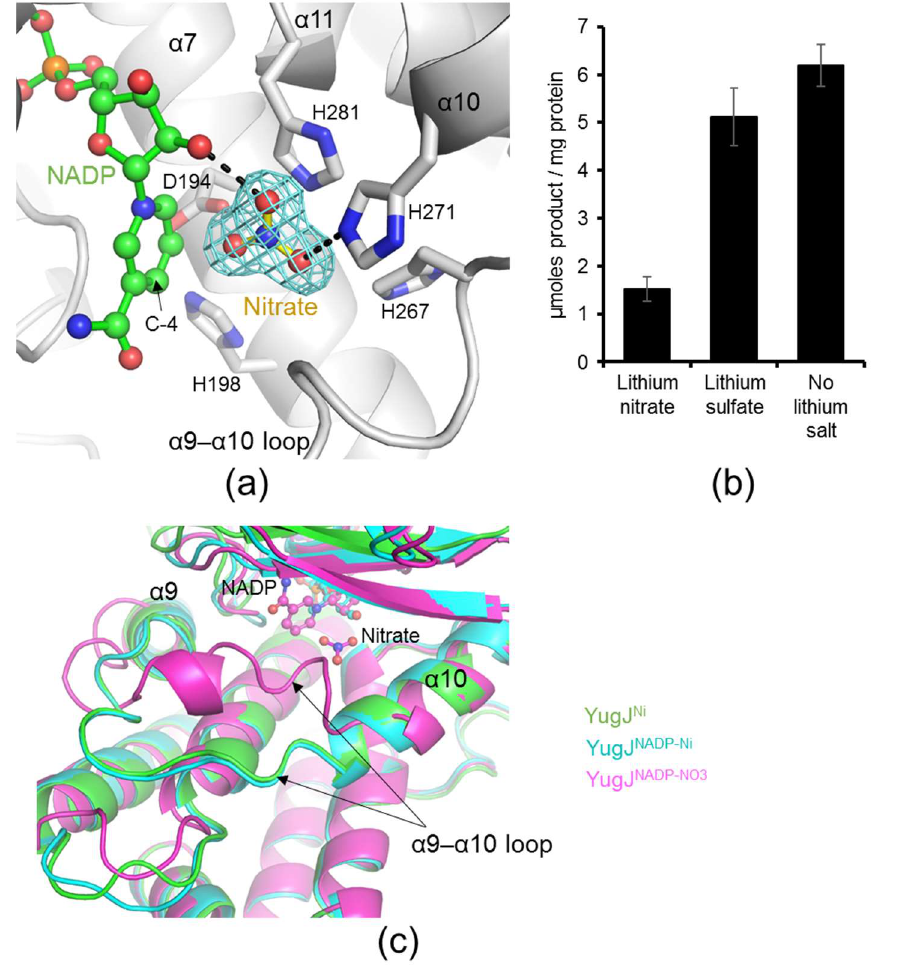
Figure 4. Nitrate binding of YugJ and inhibitory activity of nitrate on YugJ catalysis. ( a ) Putative substrate-binding site of YugJ at or near the nitrate ion in the YugJ NADP-NO3 structure. YugJ is depicted as gray ribbons. The NADP cofactor and nitrate ion are shown as ball-and-stick models, as shown in Figure 3b. The electron density of the nitrate ion (3 σ in the Fo − Fc omit map) is represented by cyan meshes. The nitrate-binding and metal-coordinating residues of YugJ are shown as gray sticks on the YugJ structure. The hydrogen bonds of the nitrate ion with YugJ residues and NADP are represented by black dotted lines. ( b ) Nitrate-specific inhibition of YugJ activity. The HMF reduction activity of YugJ was determined in the presence of lithium nitrate or lithium sulfate. ( c ) Closed state of the α 9– α 10 loop lid in the YugJ NADP-NO3 structure (magenta ribbons) in contrast to an open state in the YugJ NADP-Ni (cyan ribbons) and YugJ Ni (green ribbons)